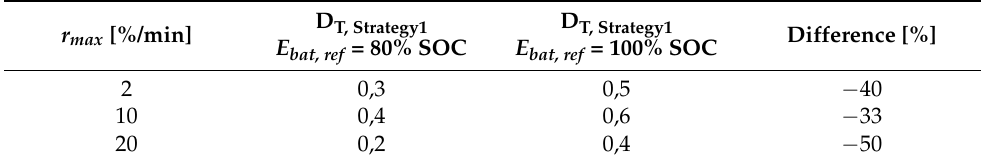
Table 4. E bat, ref action in Strategy 1 using the SimSES degradation